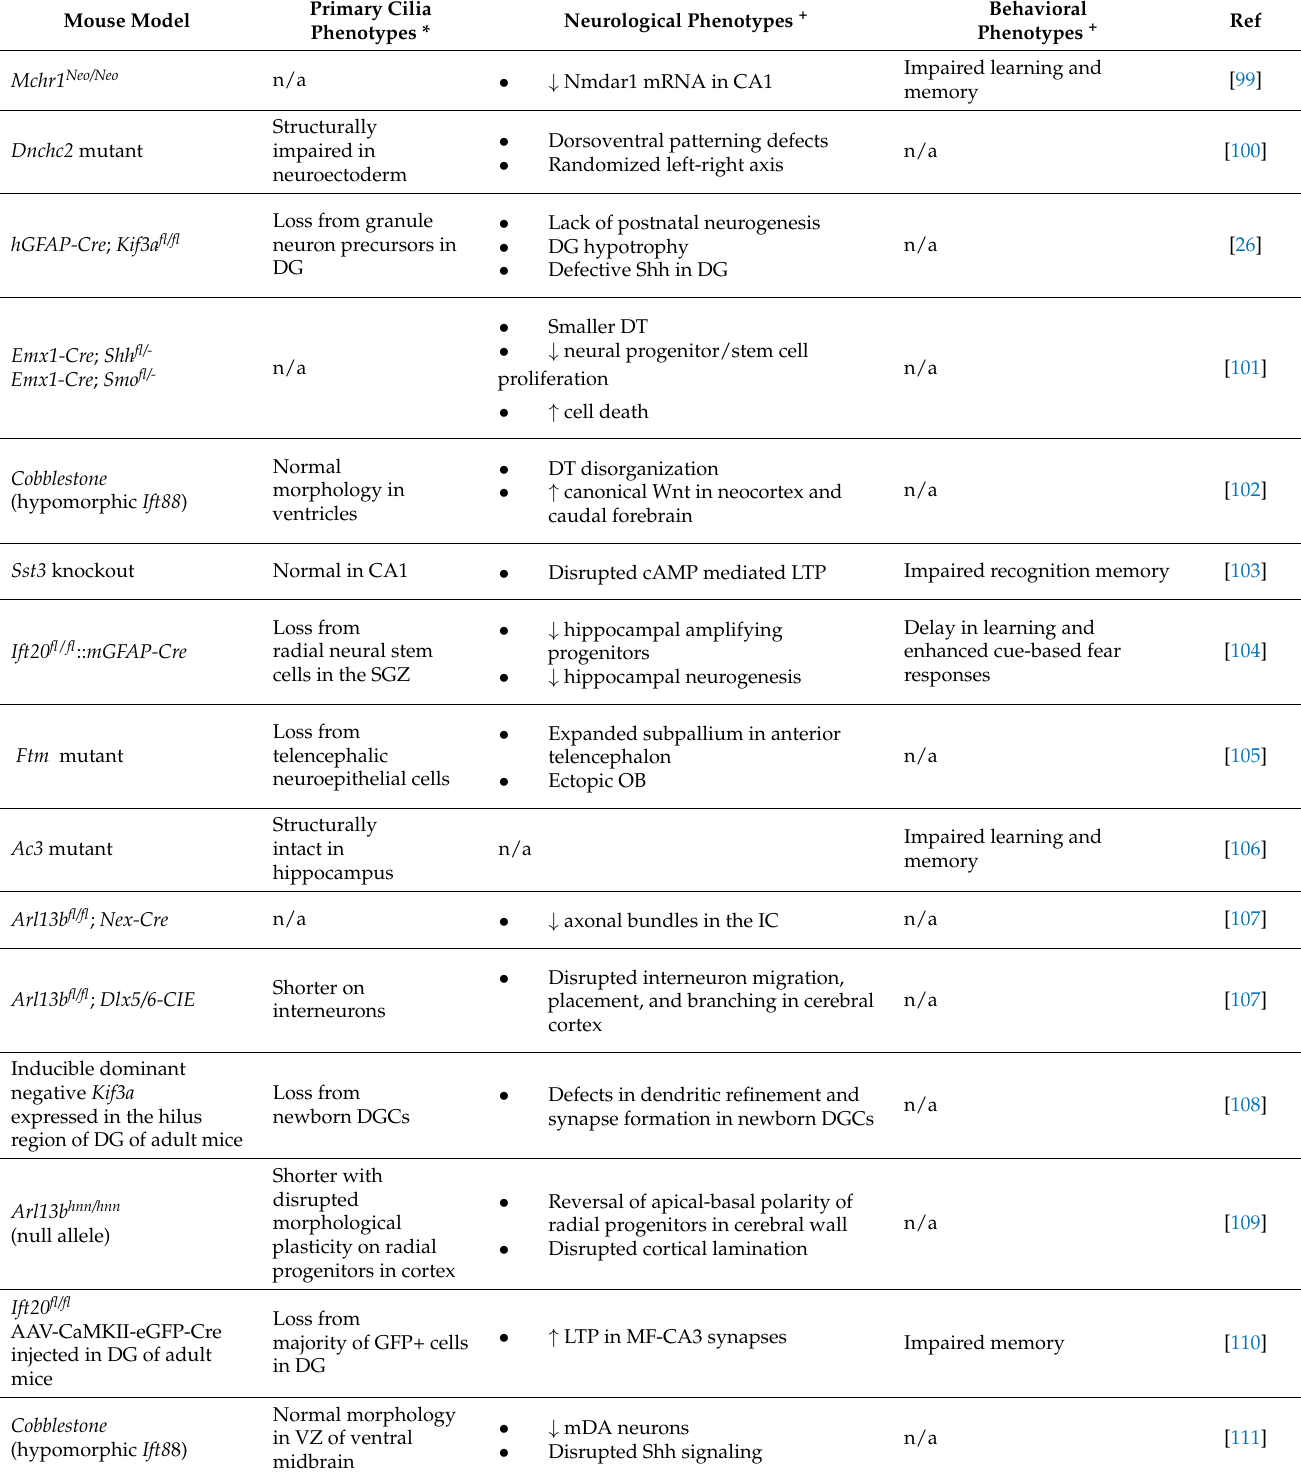
Table 2. Ciliary, neurological, and behavioral phenotypes observed in primary cilia deficit mouse